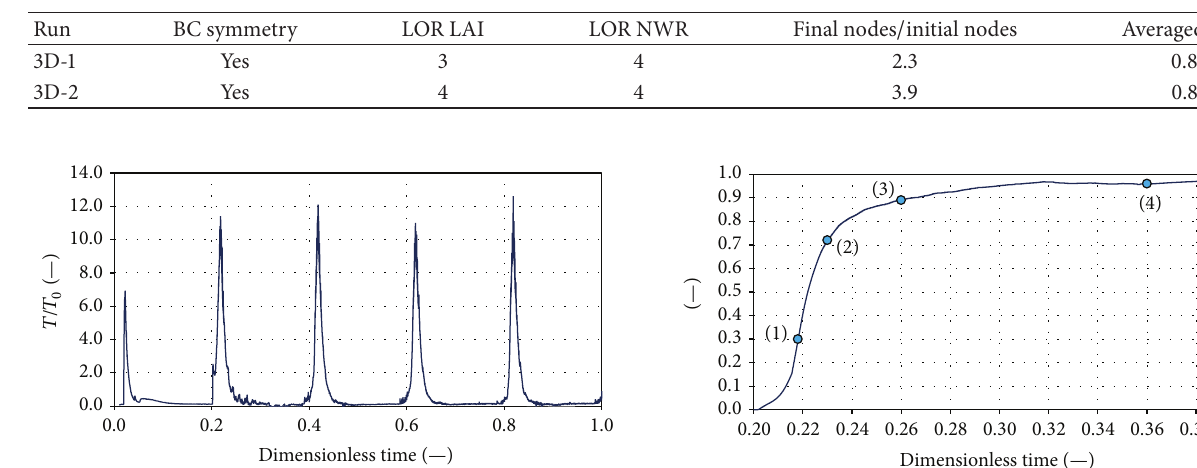
Table 7: Modelling parameters adopted in the reference geometry simulations.